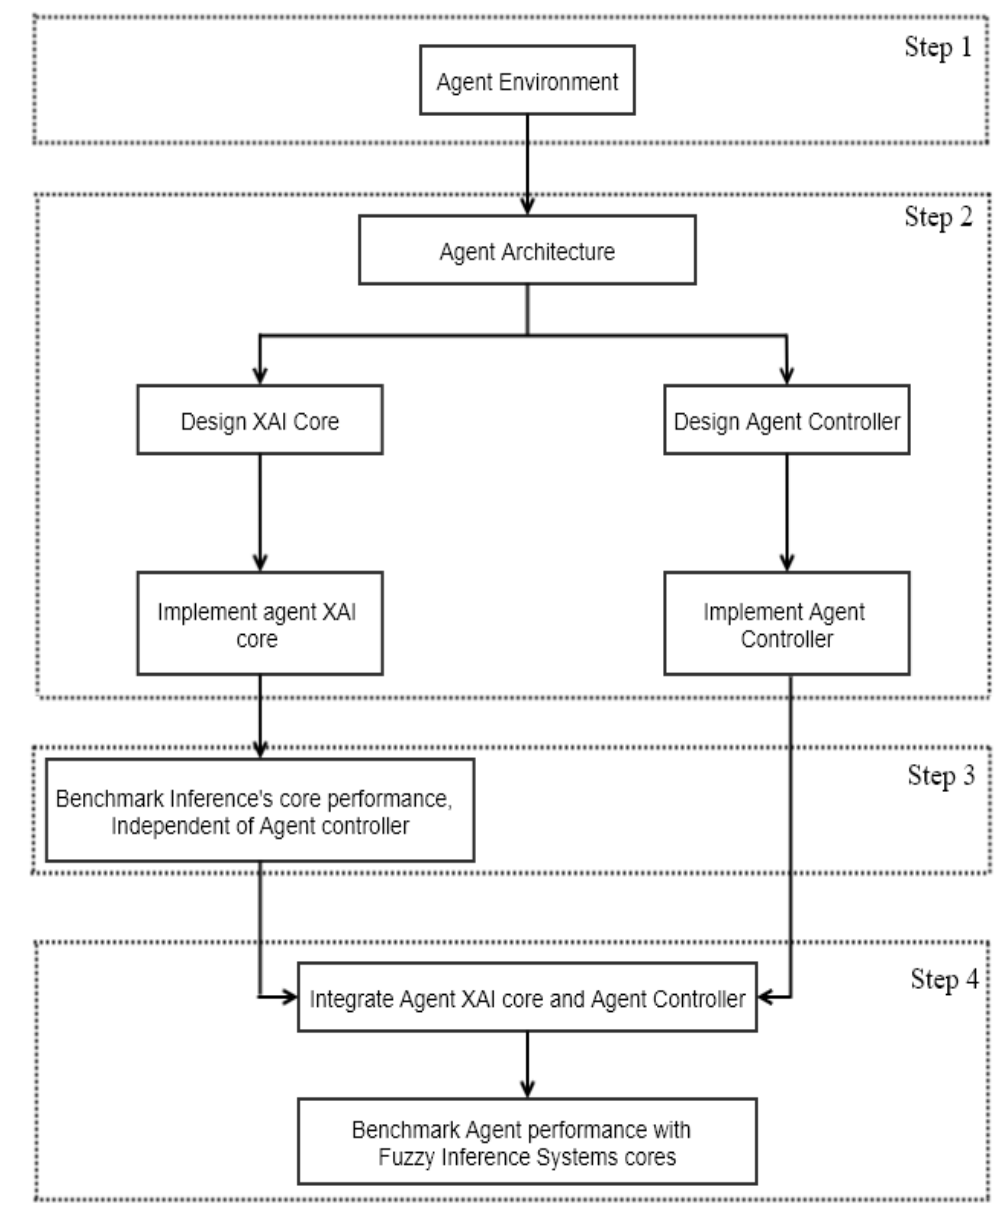
Figure 1. Flowchart of the competition framework and proposed methodology.